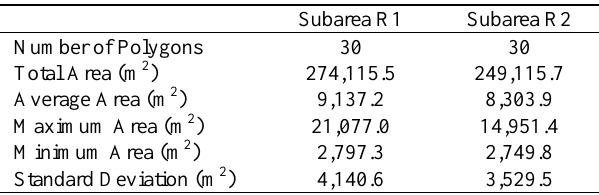
Table 1. Statistics from the reference polygons digitized on R1 and R2